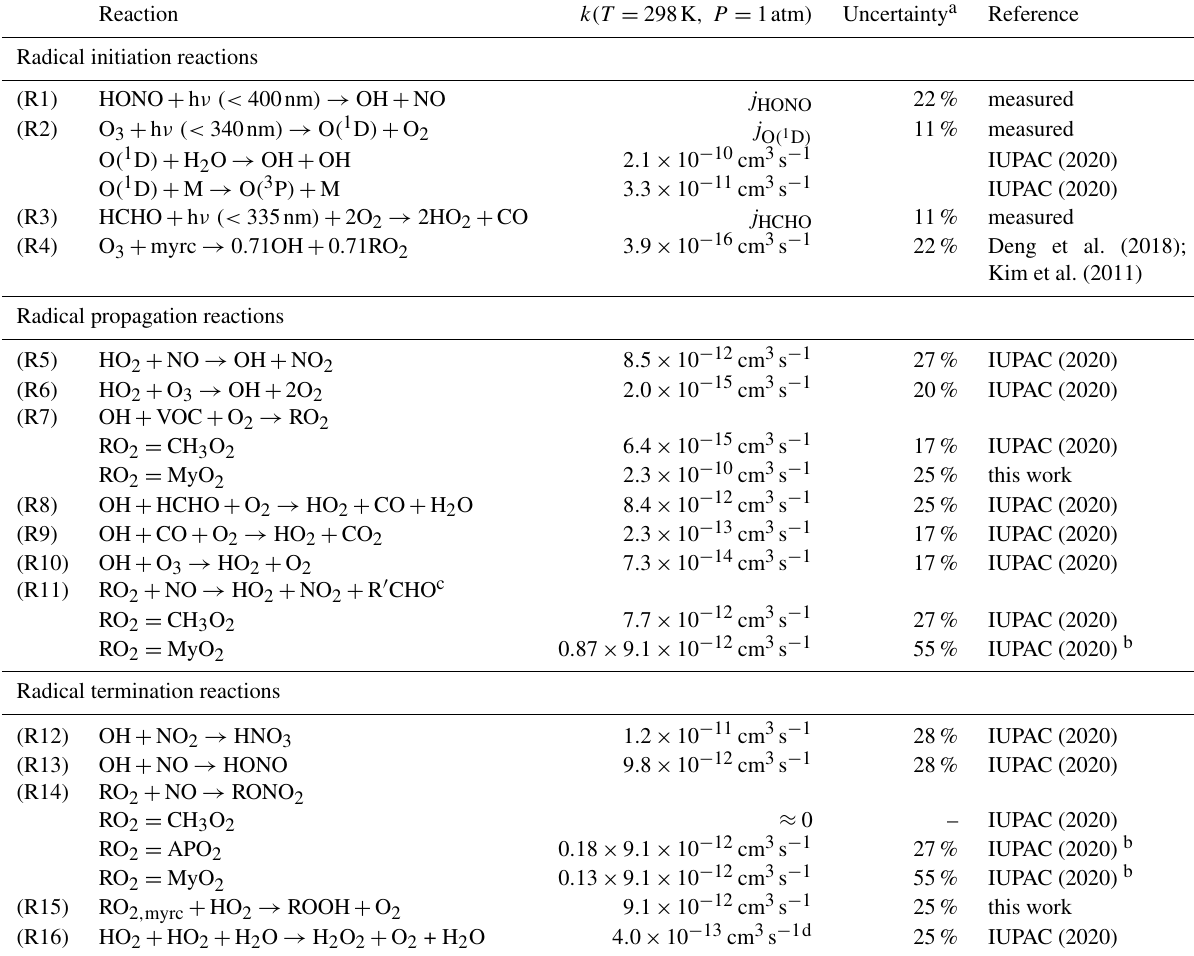
a Uncertainty measurements (Table 2) and kinetic rate constants (10 % for reactions of inorganic and methyl peroxy radicals and 15 % for other). b Reaction rate constant: IUPAC (2020); the branching ratio of 0.87 is taken from this work. c The dominant reaction of alkoxy radical is to form HO 2 , which is not rate limiting for RO 2 -to- HO 2 conversion. d Effective reaction rate constant for 1 % H 2 O mixing